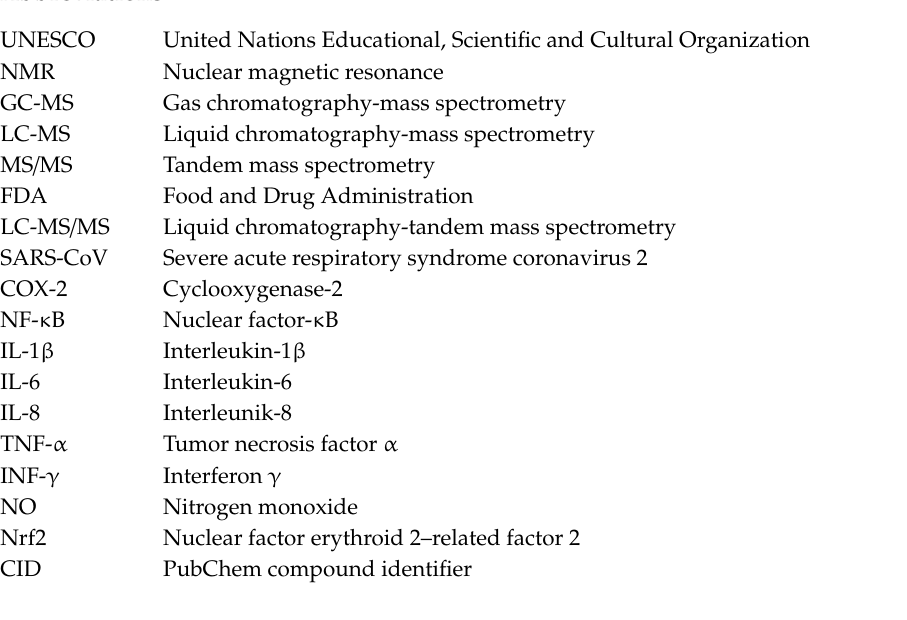
Table S1: List of the compounds identified in “asz ú ” and “furmint” wines. The novel and previously annotated components identified in wine are highlighted in bold and italics, while the novel compounds without annotation are highlighted in bold, Table S2: Compound annotation based on the PubChem BioAssay database, Table S3: Compound annotation based on the PUG-View database, Table S4: Identified wine compounds with antiviral, anti-inflammatory and anticancer activity based on the BioAssay database and literature mining, Table